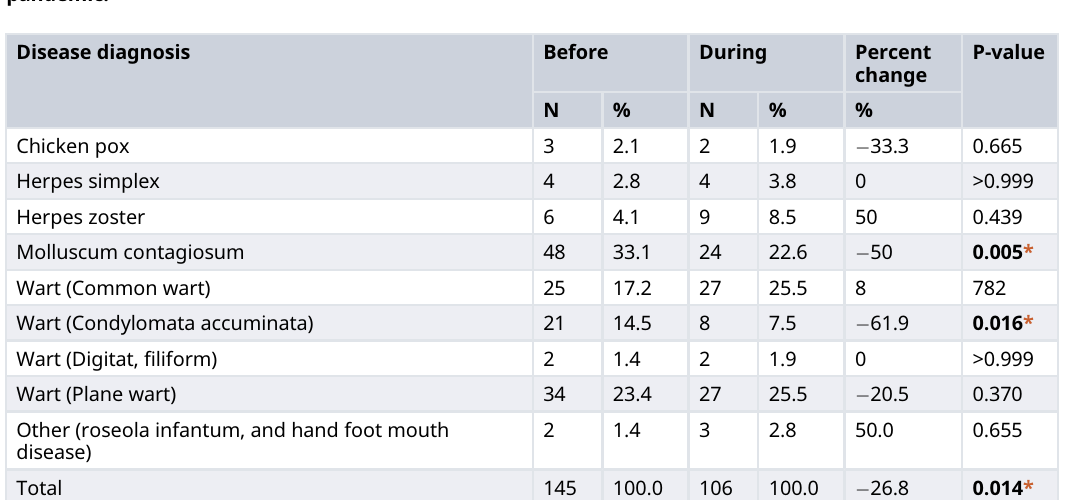
There was a reduction in the percentage of the most common forms of cutaneous bacterial infections after the peak of the COVID-19 pandemic, but it was not statistically significant (Table 3). Dermatophytosis increased while cutaneous candidiasis decreased but neither were statistically significant (Table 4).